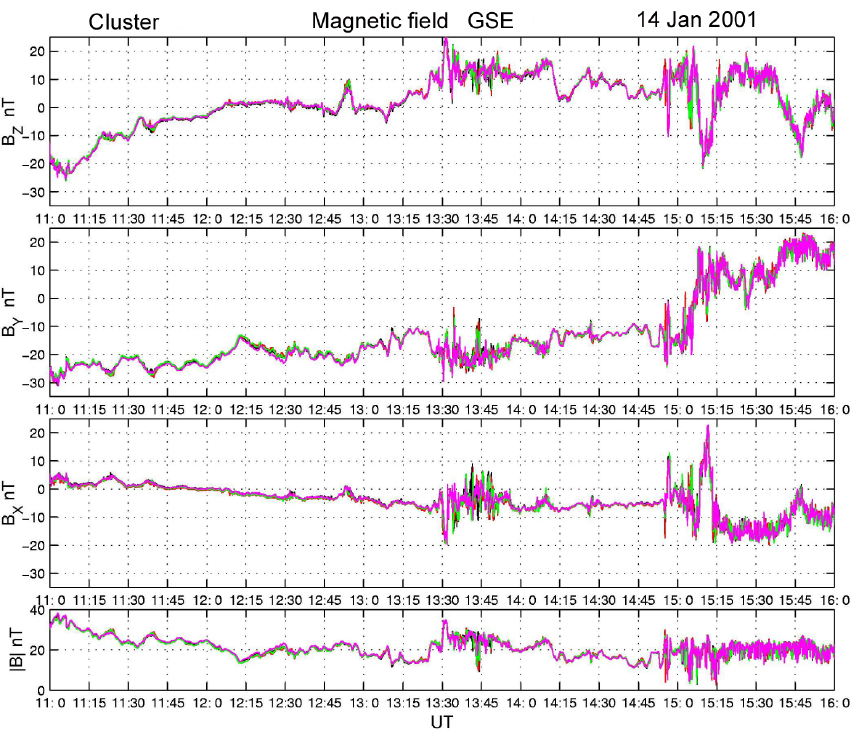
Fig. 2. The magnetic field observed by the four Cluster spacecraft at 11:16UT on 14 January 2001. The plots shows the B X , B Y and B Z components in the GSE frame and the field magnitude | B | . Data from spacecraft C1, C2, C3 and C4 are coloured (respectively) black, red, green and magenta. (Note: in this figure, data have been plotted in the order of C1, C2, C3 and then C4 and since the data are very similar on this time scale, the magenta line for C4 has covered much of the other three